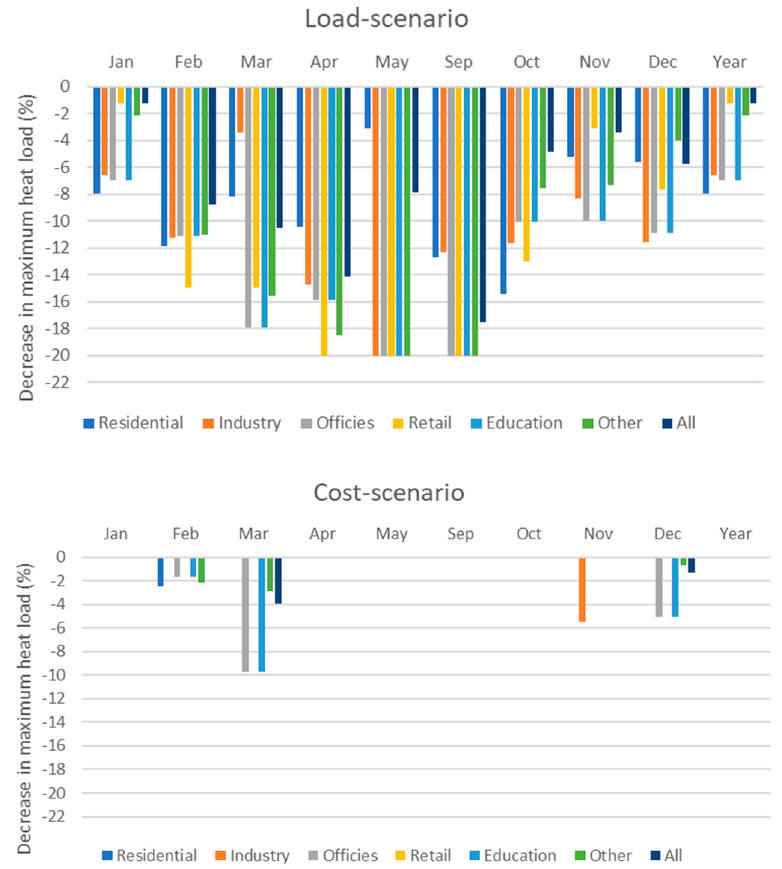
Figure 4. The monthly peak heat load for different customer segments in the Load and Cost